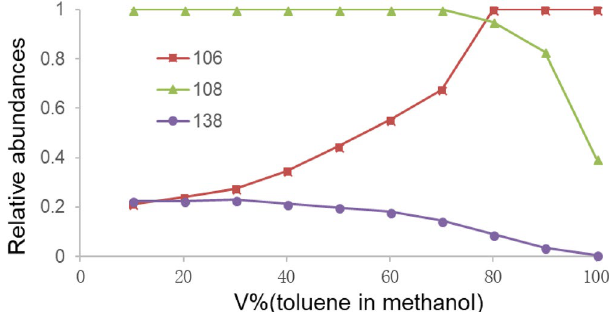
Figure 4. Relative abundances of the product ions along with the toluene proportion.